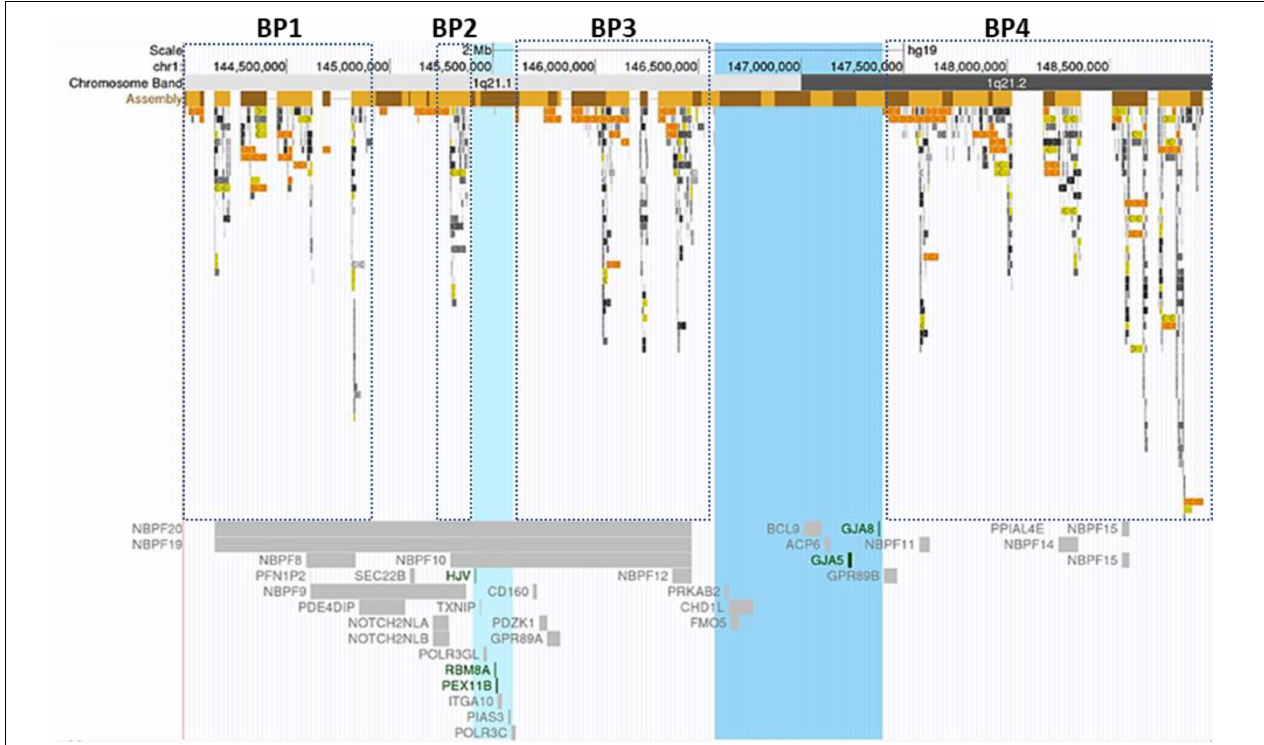
FIGURE 4 | Segmental duplications and Online Mendelian Inheritance in Man (OMIM) documented genes at the 1q21.1 region. Breakpoint regions (BP1–BP4) in dotted squares were delineated according to Mefford et al. (2008). Highlighted in light blue was the minimal thrombocytopenia-absent radius deletion/proximal 1q21.1 duplication region; the blue-colored band represented the core region of class I deletions/duplications. Low copy repeats with varied sequence similarity were highlighted with different colors. Light to dark gray: 90–98%, light to dark yellow: 98–99%, and light to dark orange: > 99%. The figure was generated using the University of California, Santa Cruz Genome Browser (Bailey et al., 2001, 2002). Green color genes: the molecular mechanism for the gene-associated disorders has been demonstrated. Gray color genes: the gene-related OMIM phenotype was not